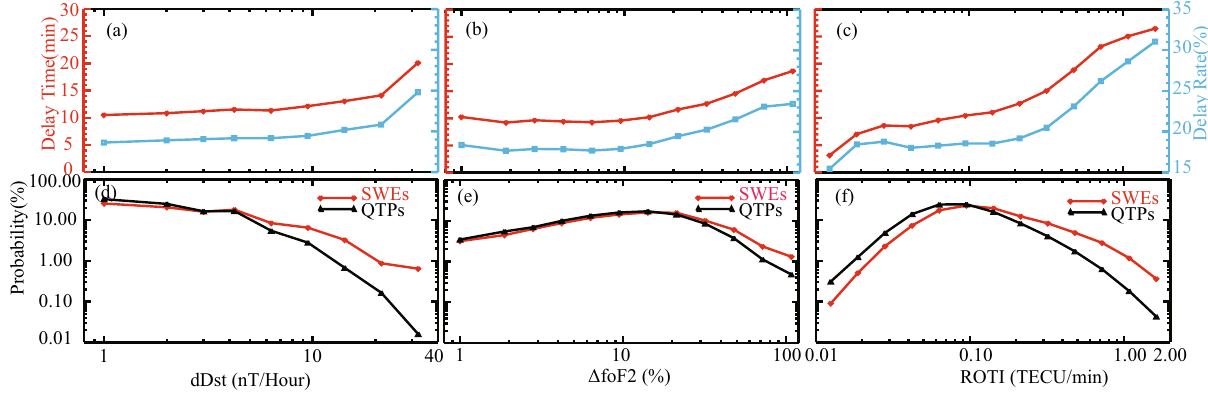
Figure 3. The distributions of flight delay time (red) and 30-min delay rate (blue) as a function of dDst ( a ), ∆foF2 ( b ) and ROTI ( c ) calculated from all flight records. The probability distributions of dDst, ∆foF2 and ROTI during SWEs (red) and QTPs (blue) are also shown in panel ( d ), ( e ), ( f